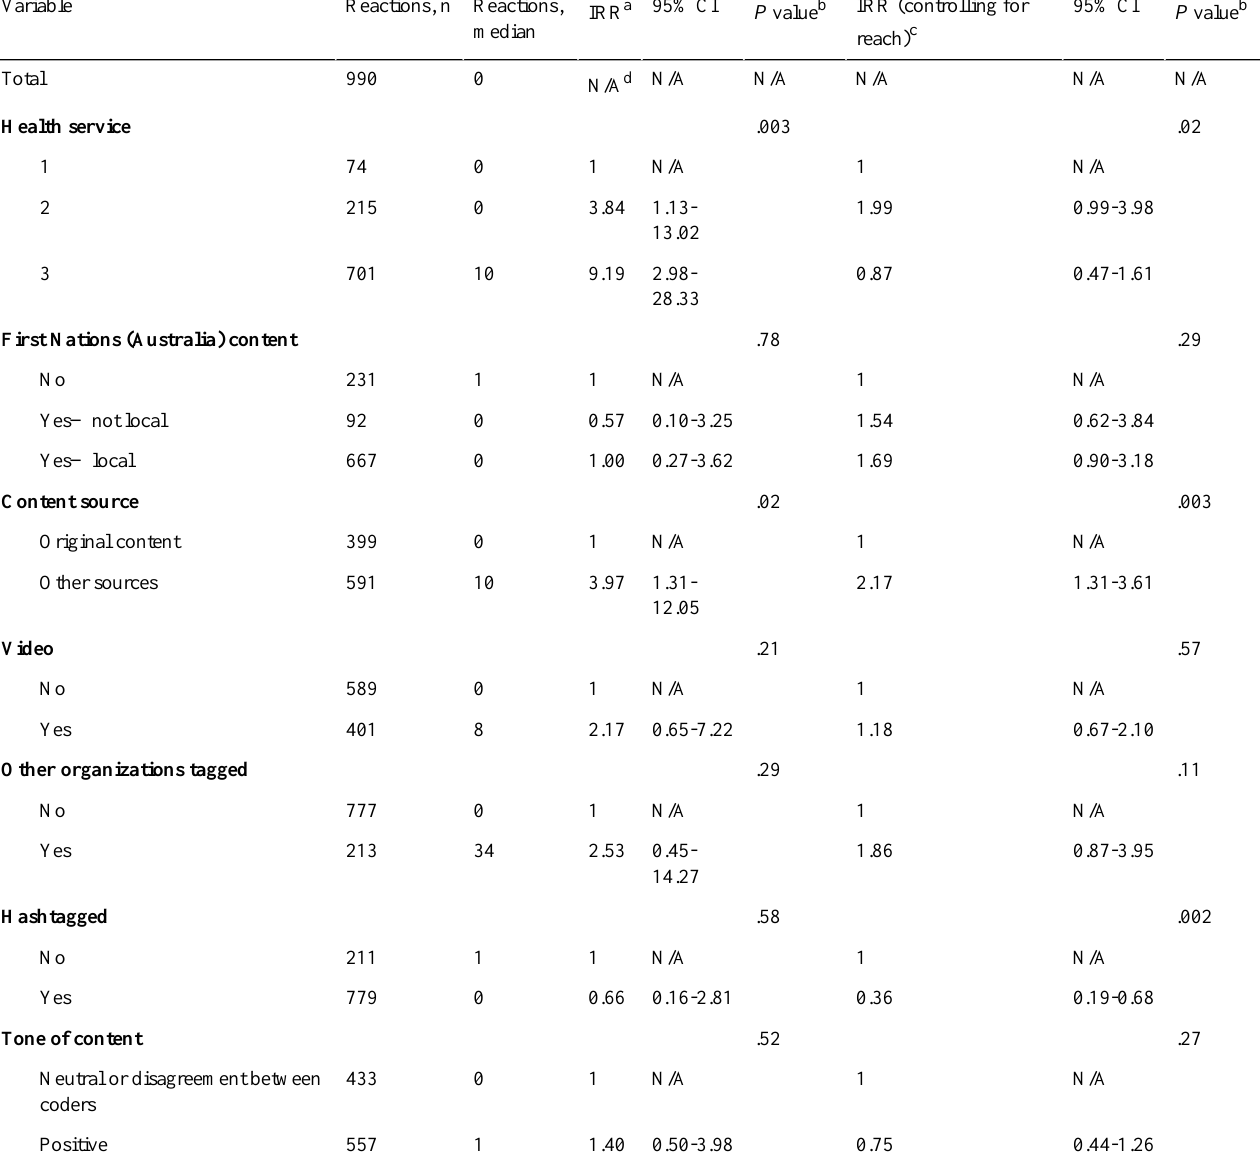
P value b 95% CIIRR (controlling